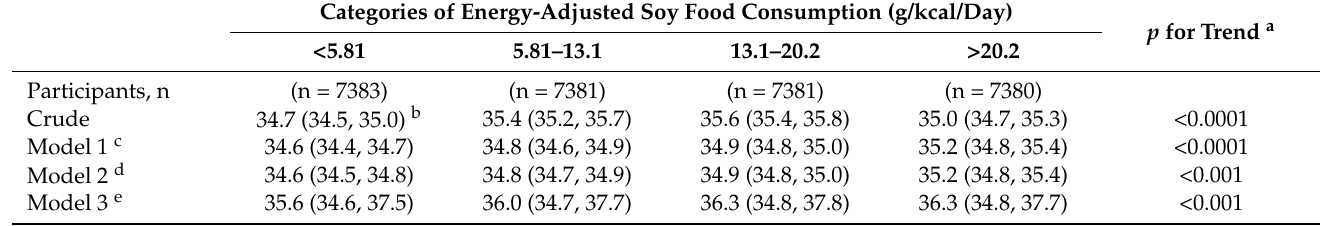
Table 4. Association of energy-adjusted soy food consumption with handgrip strength (n = 29,525). Categories of Energy-Adjusted Soy Food Consumption (g/kcal/Day)